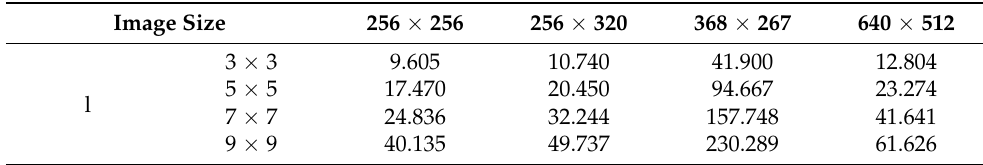
Table 1. The running time (millisecond) of the proposed